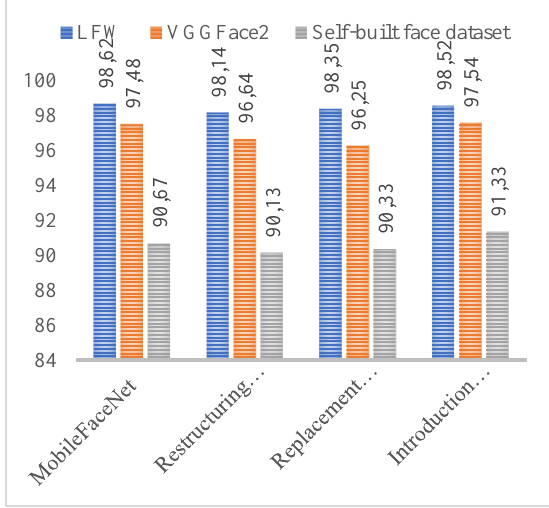
Figure 14. Recognition accuracy in